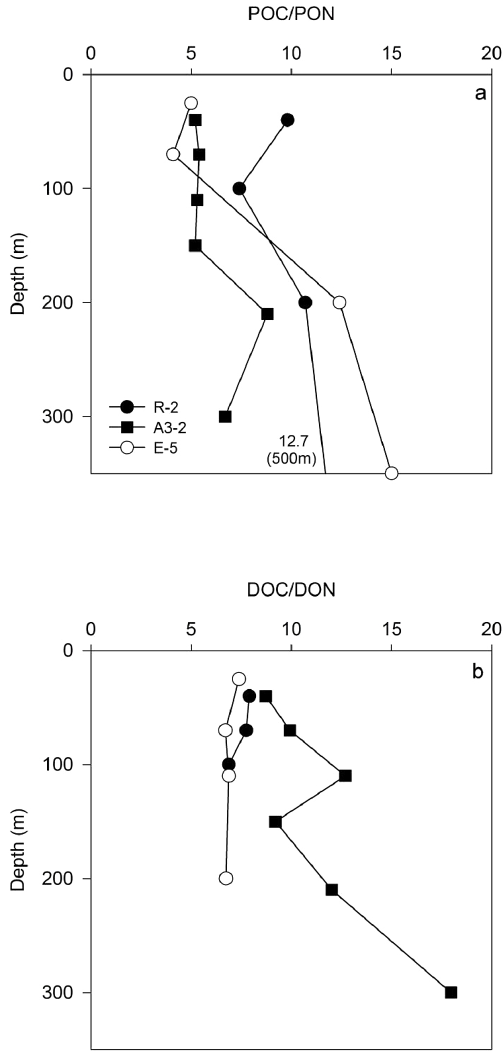
Figure 1. Carbon to nitrogen atomic ratios in the (a) particulate and (b) dissolved fractions for three representative stations (R-2, A3-2, E-5) at 0-350m depth. The value close to the station R-2 profile is the next data point at 500m. Ratios cannot be quantified at certain depths because elementary data were not available (Table